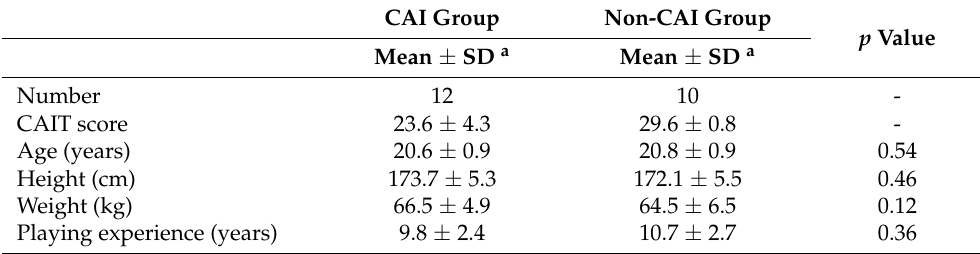
Table 1. Physical characteristics of the CAI and the non-CAI groups.